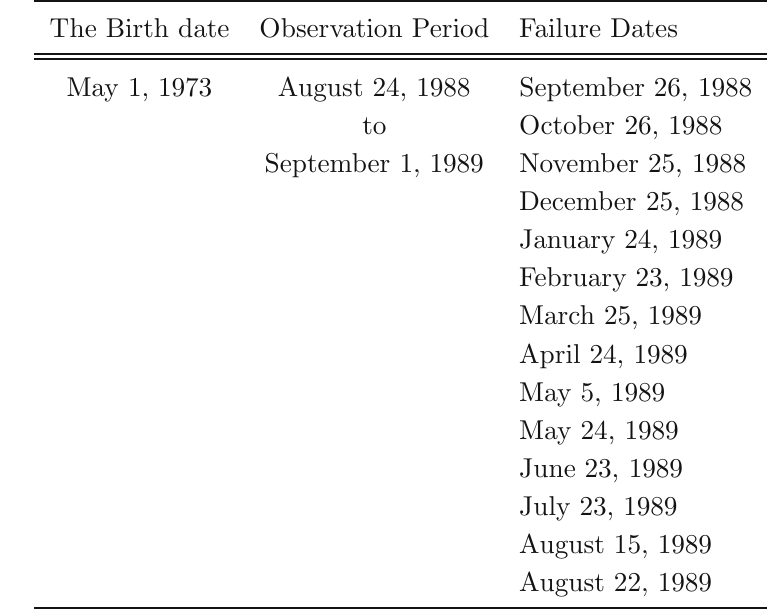
Table 1 Failure Data of CGD.